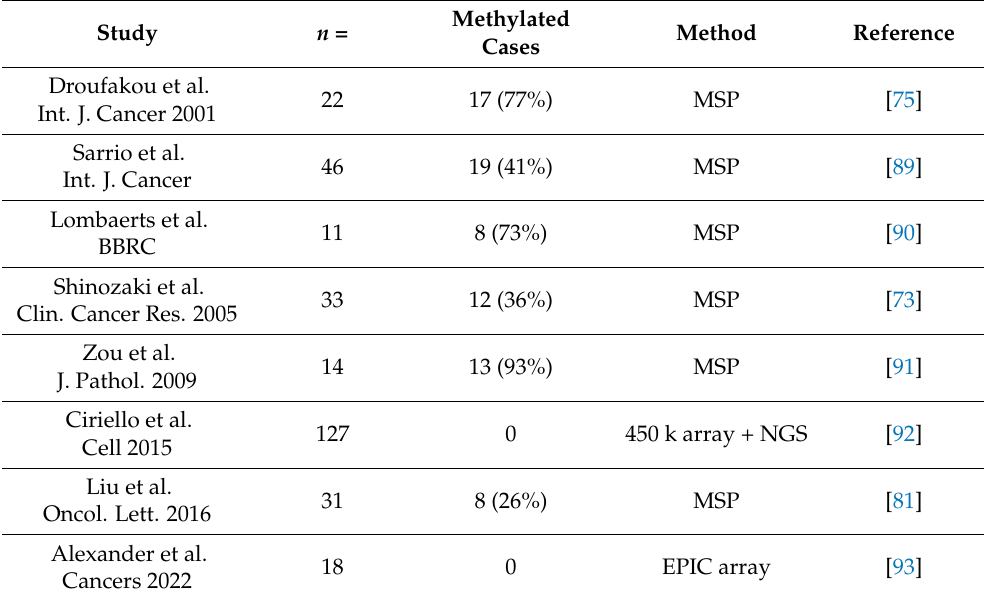
Table 1. Detailed overview of the studies reporting CDH1 gene methylation in lobular breast cancer. Only publications analyzing more than 10 cases of lobular breast cancer are included. Methylated Study n = Method Reference Cases Droufakou et al. Int. J. Cancer 2001